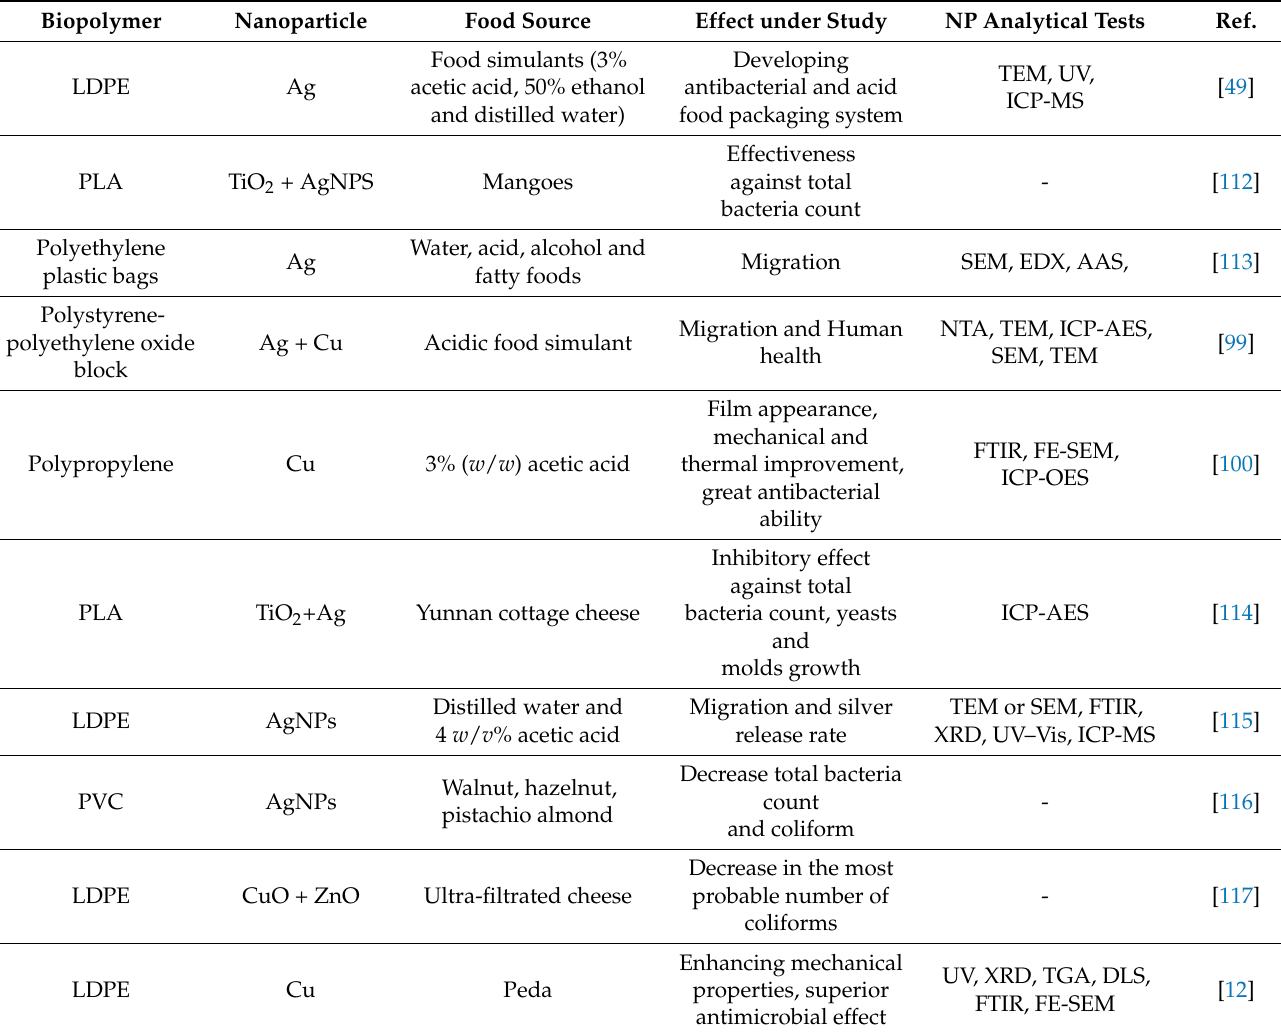
Table 2. Applications of Ag/Cu NP systems in food packaging, their effect under study, and analytical methods for their